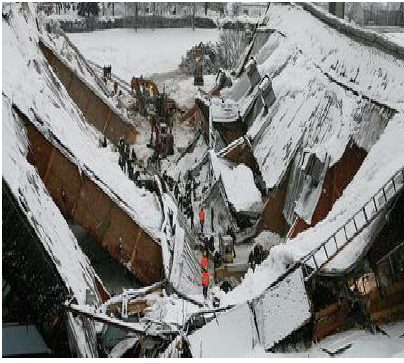
Figure 2. Bad Reichenhall Skating hall.